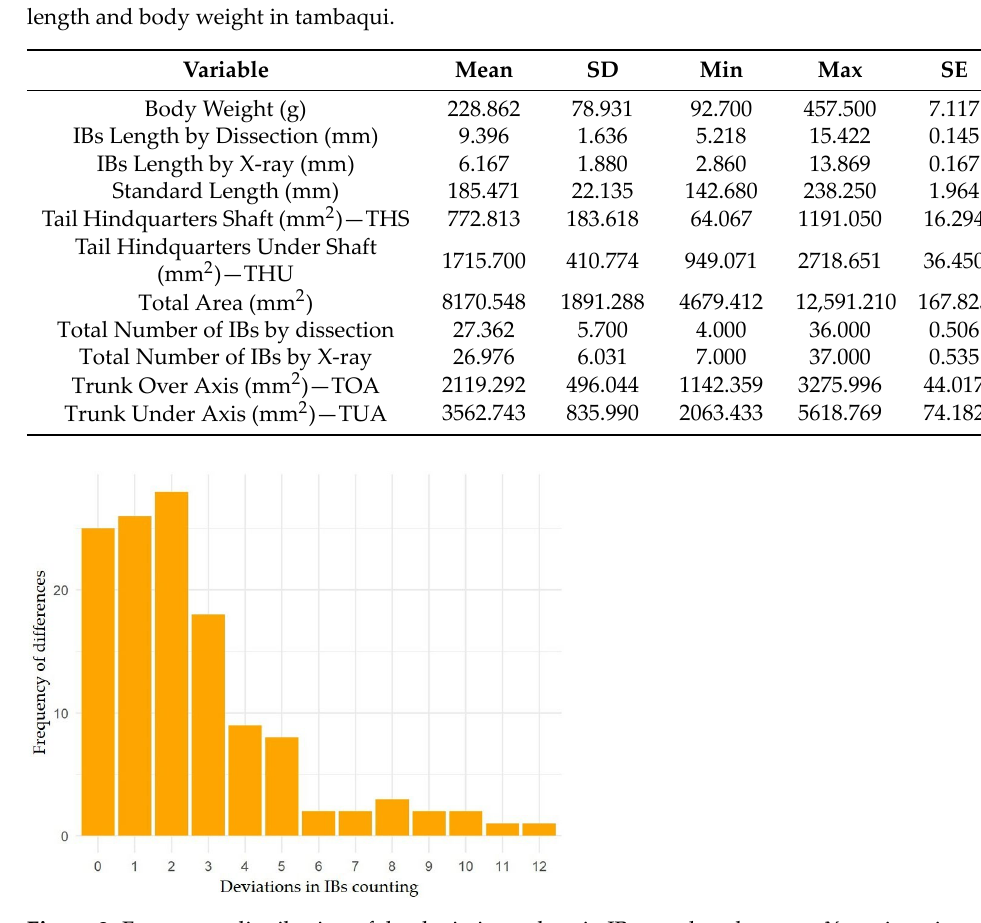
Figure 3. Frequency distribution of the deviation values in IBs numbers between X-ray imaging and dissection methods in tambaqui.